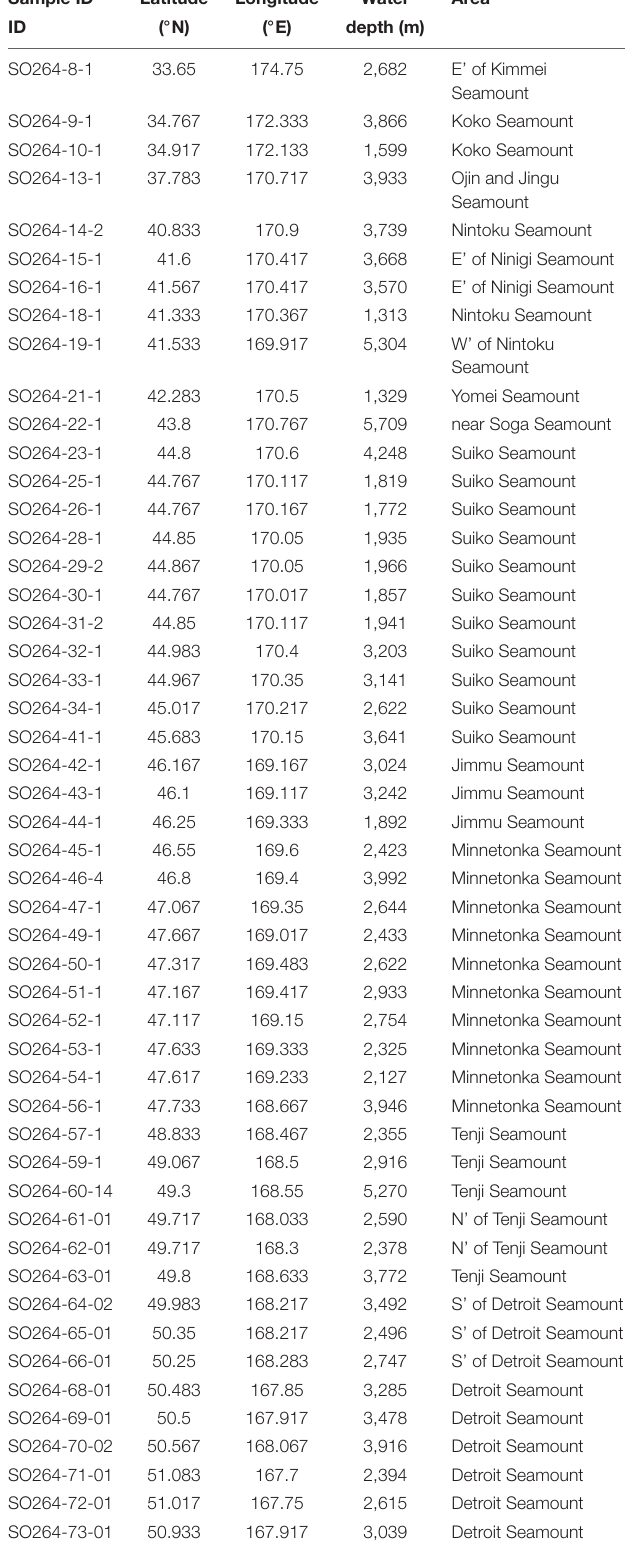
TABLE 1 | All samples of surface sediment information are mentioned in this